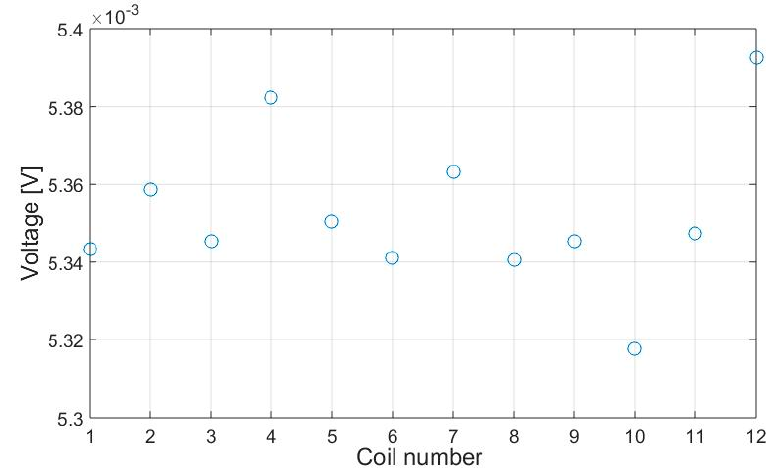
Figure 9. Zero referencing values for the used pickup coils.